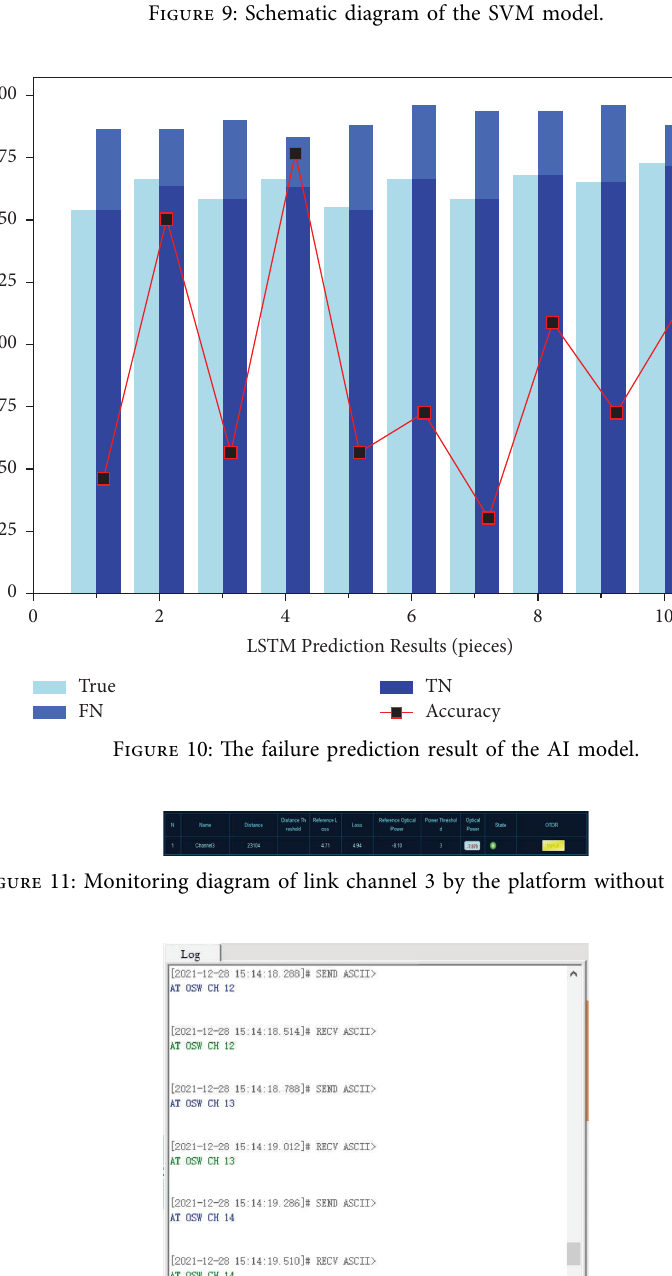
Figure 12: Logs of optical switch